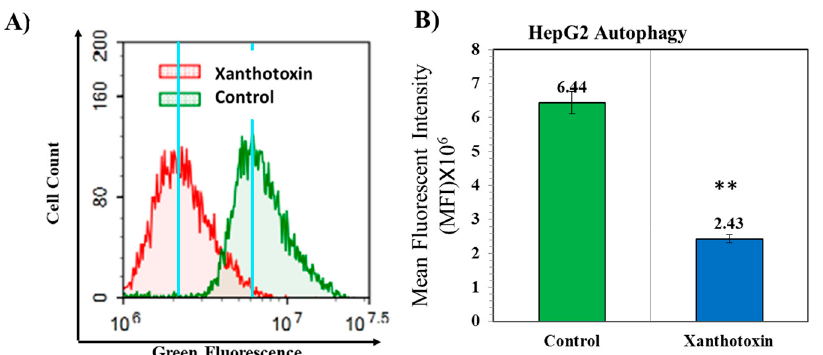
Figure 6. A graphical representation of autophagy in HepG2 cells treated with xanthotoxin. ( A ) Flow cytometric histograms representing the acridine orange autophagy flux assay of HepG2 seeded at 2 × 10 3 cells for 48 h in complete DMEM and treated with 6.9 µ g/mL xanthotoxin compared with control cells. ( B ) Diagrams of the percentage of necrosis and apoptosis for xanthotoxin in comparison with control cells. All analyses were carried out in triplicates, and values are expressed as means ± SEM. ** denote significant difference at p < 0.01.